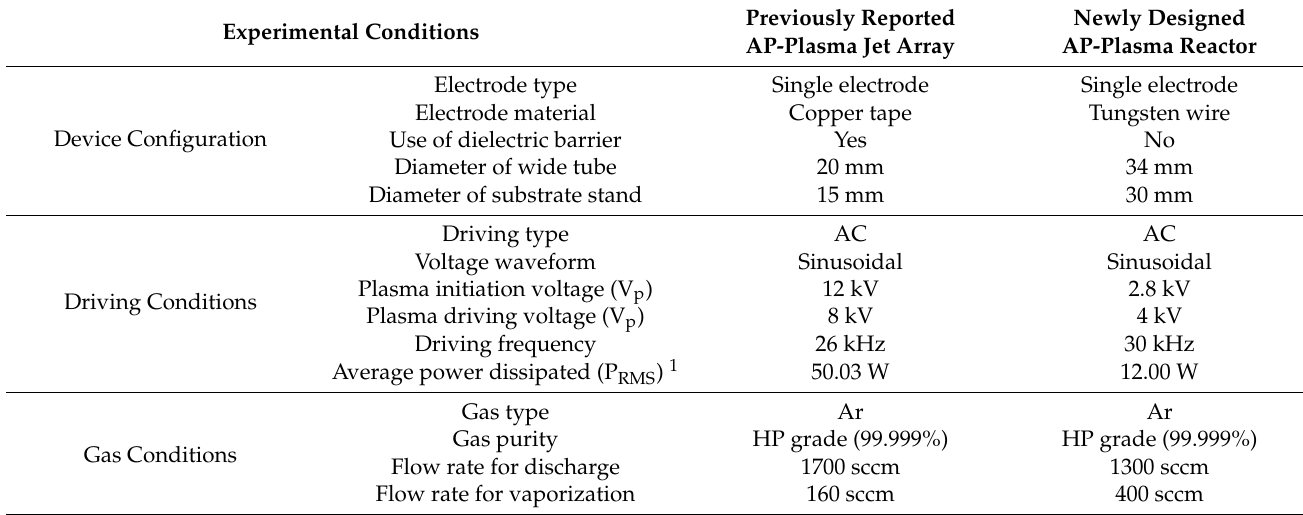
Table 1. Summarized experimental conditions using the previously reported APPJ array reactor [11,13] and the newly designed AP-plasma reactor for AP-plasma